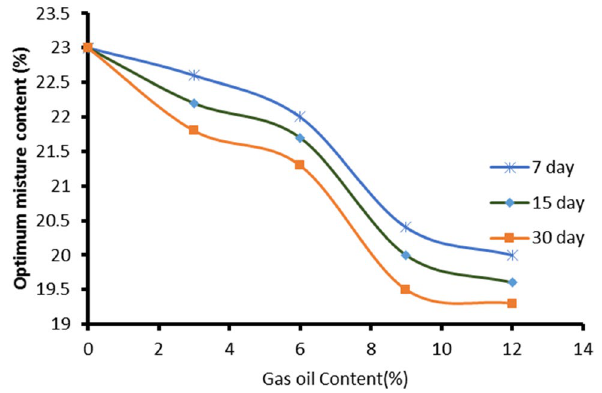
Fig. 15 Relationship between moisture and gasoline content at dif- ferent ages